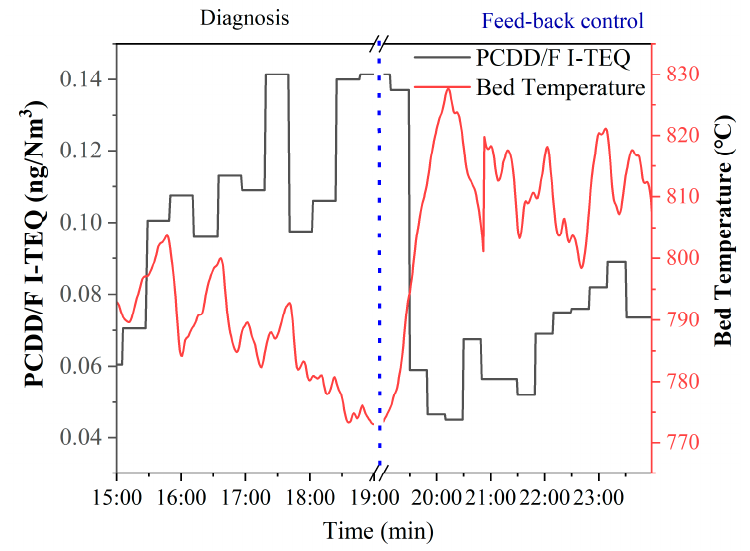
Figure 12. Diagnosis and feedback control of PCDD/F based on bed temperature.